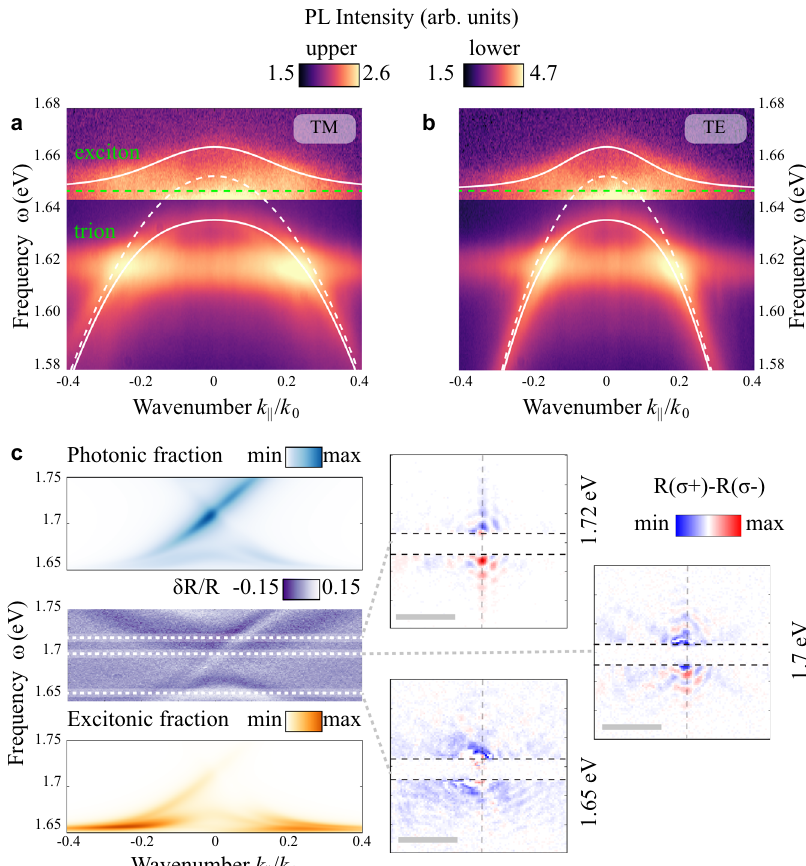
Fig. 4 Photoluminescence and propagation of MoSe 2 TPs. Angle-resolved photoluminescence maps for TM-( a ) and TE-( b ) polarized collection in logarithmic scale. The sample is excited non-resonantly with CW laser at ~1.96 eV. For better visibility, regions of lower and upper polariton branches are plotted in different color scales. Dispersion of the modes extracted from fi tting the PL data with coupled oscillator model are marked with lines: uncoupled photonic mode (dashed white), uncoupled exciton (dashed green) and the resulting polariton branches (solid white). c Left: angle-resolved differential re fl ectivity map for σ − -polarized light compared to the calculation of photonic and excitonic fractions in the modes via TBM model. Right: real-space maps demonstrating one-way propagation of polaritonic edge states. The maps show the differential images of the sample excited with focused σ + and σ − -polarized laser pulses with a linewidth of ~10 meV. The calculated exciton fractions for the shown frequencies are 0.05 (1.72 eV), 0.11(1.7 eV), and 1 (1.65 eV, the exciton frequency). Scale bars are each 10 µ m. Horizontal black dashed lines enframe the beam stop that blocked the directly re fl ected light. Vertical dashed lines represent the position of the domain ffiffiffiffiffiffiffiffiffiffiffiffiffiffiffiffiffiffiffiffiffiffiffiffiffiffiffiffiffiffiffiffiffi s ð γ (cid:2) γ Þ 2 ph ex κ 2 (cid:2) : ð 7 Þ 4 From data fi tting for both TE and TM polarized PL using Eqs.